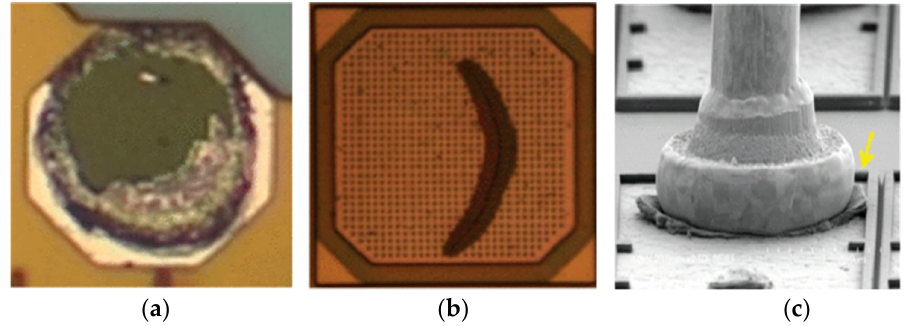
Figure 4. Schematic diagram of pad defects during bare Cu wire bonding: ( a ) pad peeling; ( b ) pad crack; ( c ) Al splash [72]. Copyright, 2015, IEEE.